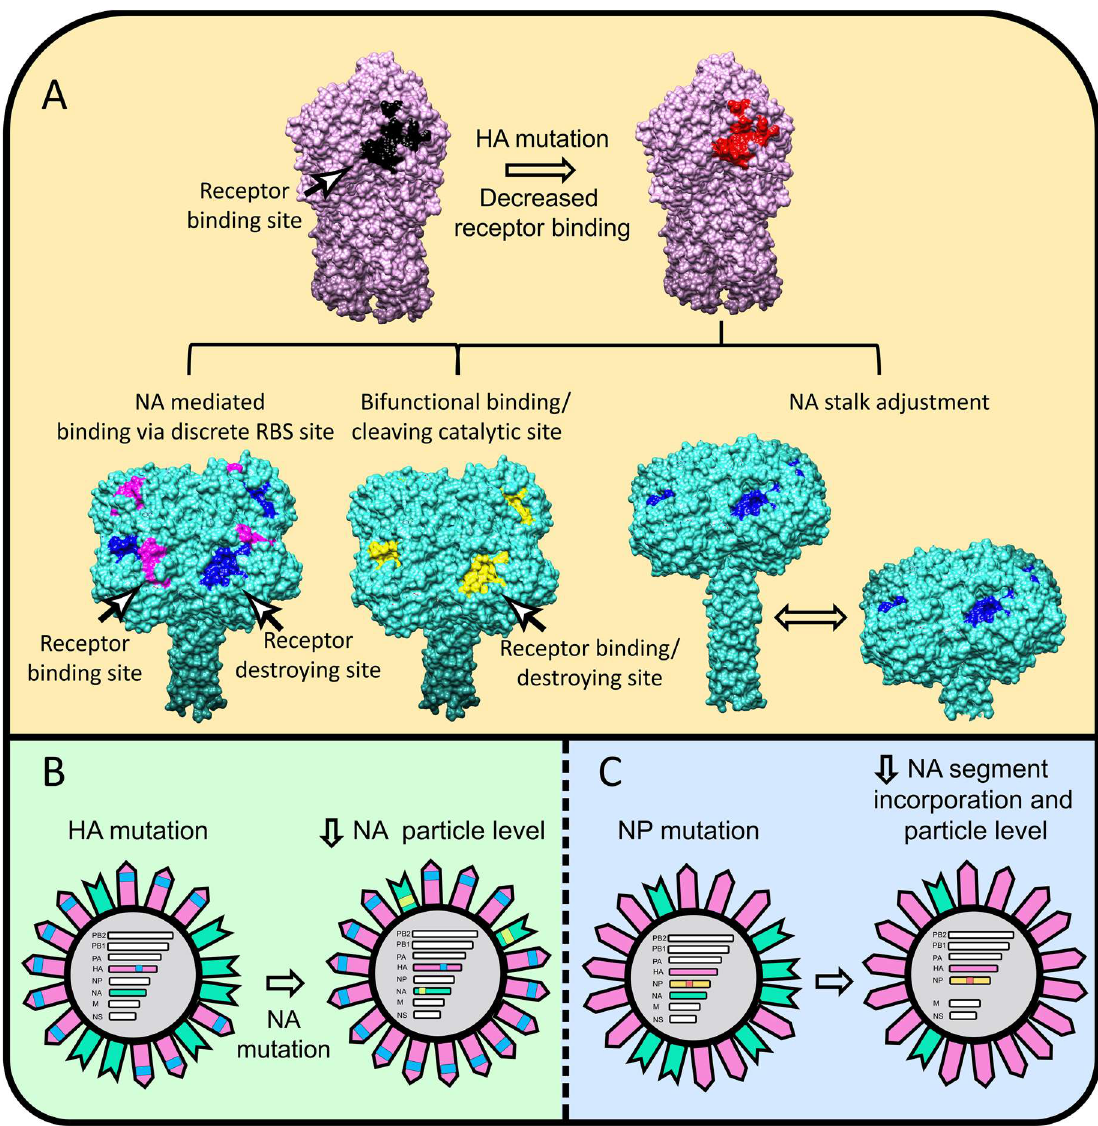
Figure 1. Naturally observed mechanisms to optimize HA–NA stoichiometry. ( A ) The HA H1 (pdb entry 3lzg) is colored pink with wt-RBS in black and mutated RBS with decreased binding in red. The NA N2 is colored turquoise (the model was created by superimposition of pdb entries 2hty and 6crd-containing tetrabrachion stalk) with the receptor destroying / catalytic site in blue, receptor binding site in magenta, and combined receptor binding / destroying site in yellow. ( B ) After the HA (pink) acquires an avidity decreasing mutation (blue), the NA (green) follows with a mutation (bright green) that impairs NA intracellular trafficking and incorporation into virions. ( C ) During host adaptation an NP mutation (red-orange) can decrease NA gene segment incorporation leading to diminished amounts of virion NA to rebalance HA–NA levels. UCSF Chimera 1.13 was used to render the 3-D structures.